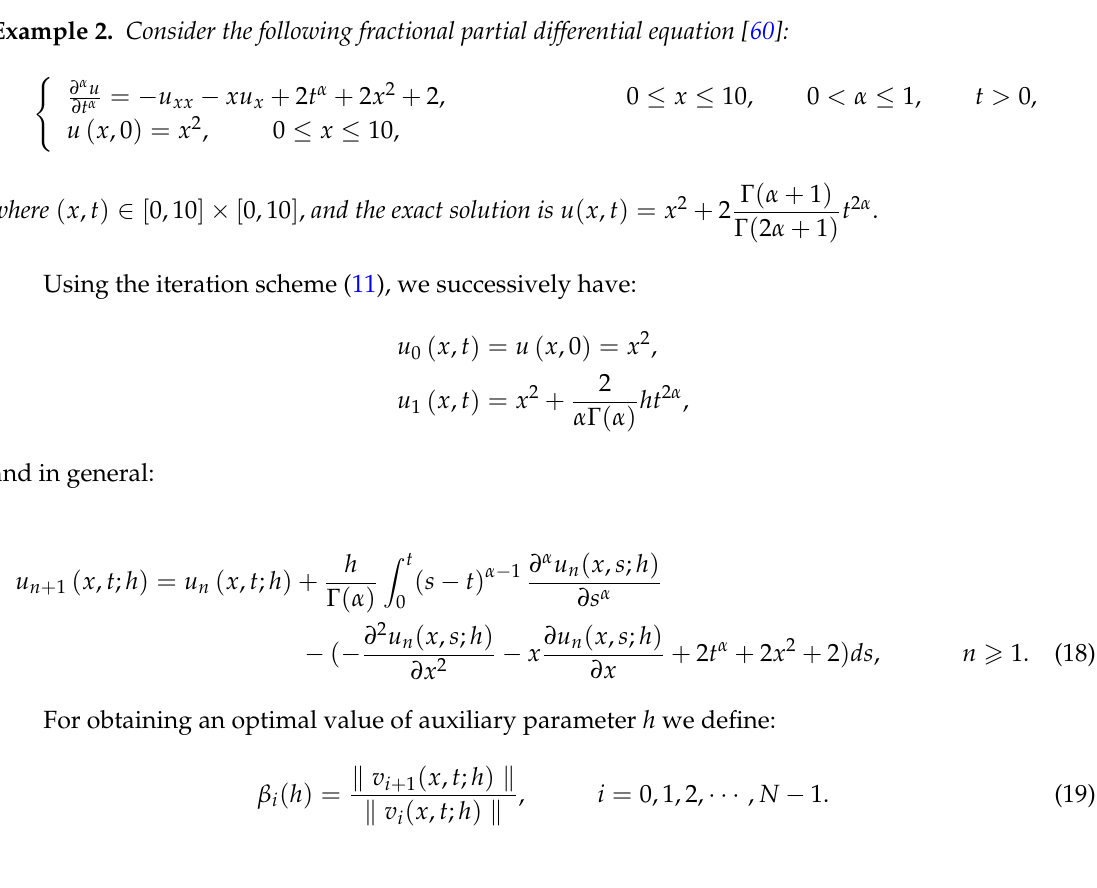
Figure 4. Absolute error for the 16th-order approximation by present method for u ( x , t ) when α = 0.9 and h = 1.1422, in Example